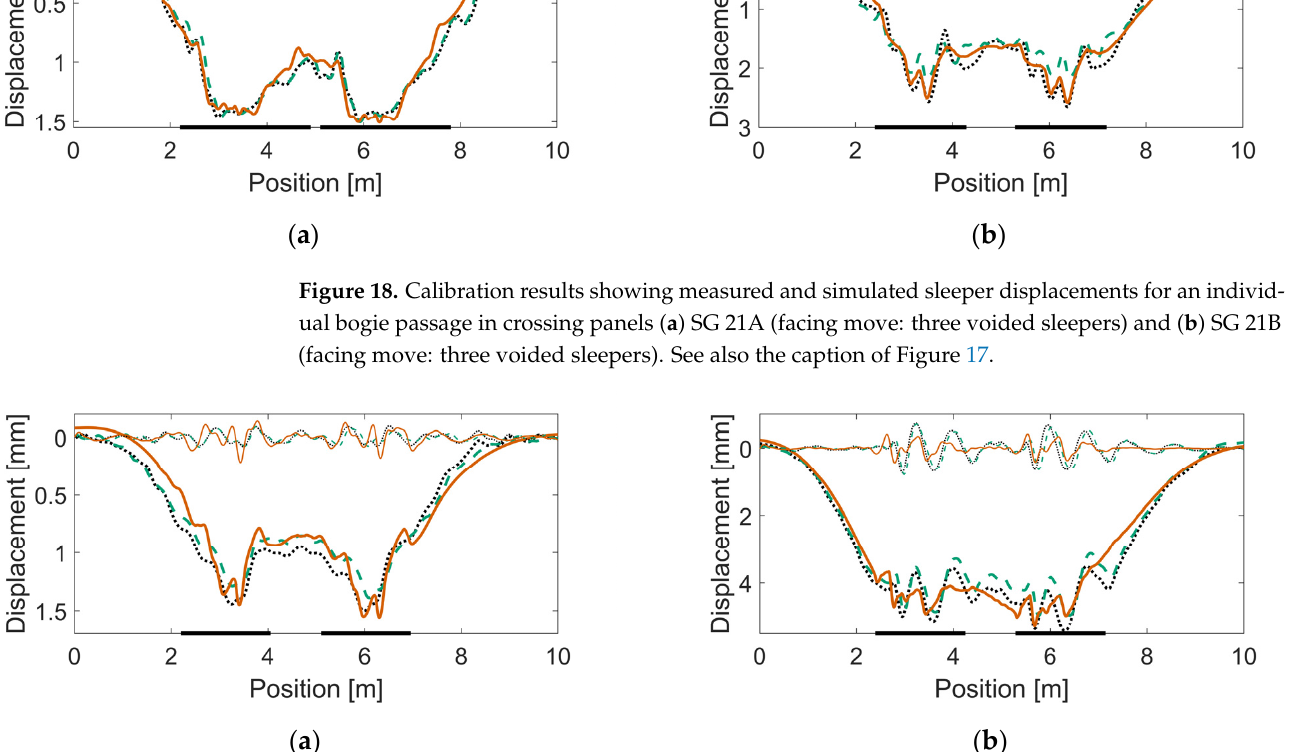
Figure 19. Calibration results showing measured and simulated sleeper displacements for an individual bogie passage in crossing panels ( a ) VAD 102 (trailing move: soft linear ballast properties) and ( b ) VAD 131 (facing move: four voided sleepers and damaged rail). See also the caption of Figure 17.